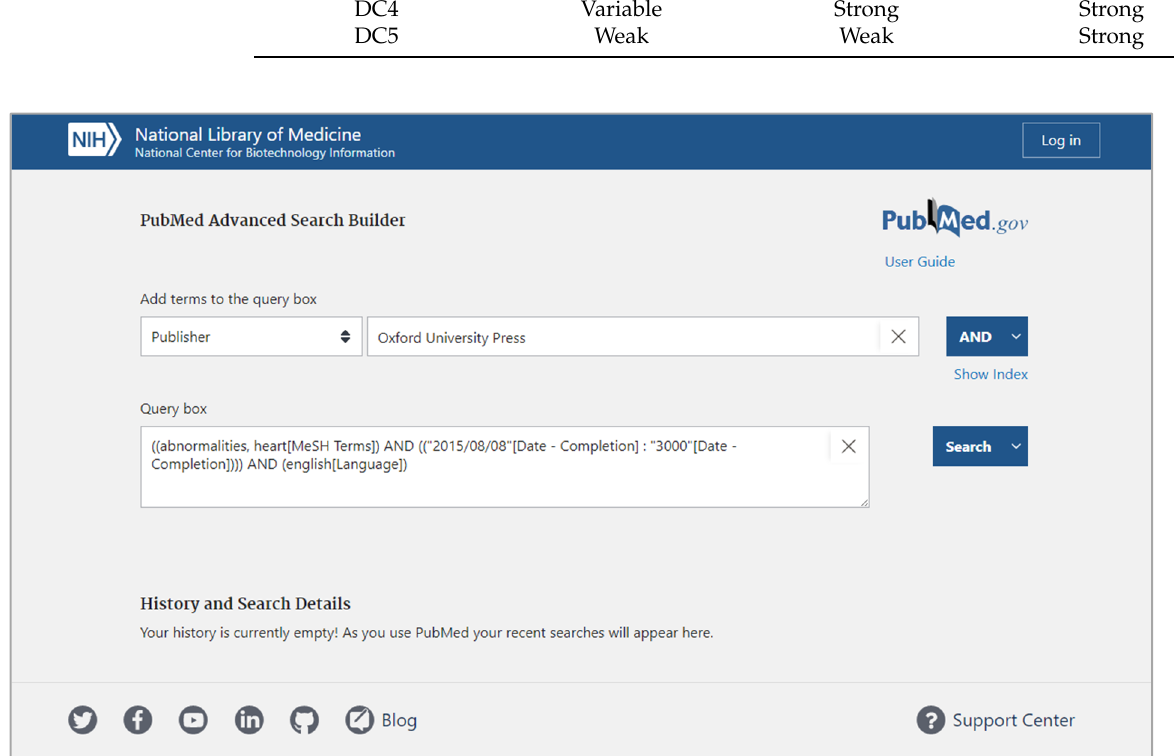
Figure 1. PubMed Advanced Search Builder: an example of a structured interface strategy for a search task. In this use case, a query item was generated for a MeSH term for heart abnormalities, a completion date after 8 August 2015, and in the English language, with the publisher of Oxford University Press soon to be added. Source: Image generated on 18 January 2021, using the public web portal provided by the National Center for Biotechnical Information, https://pub-